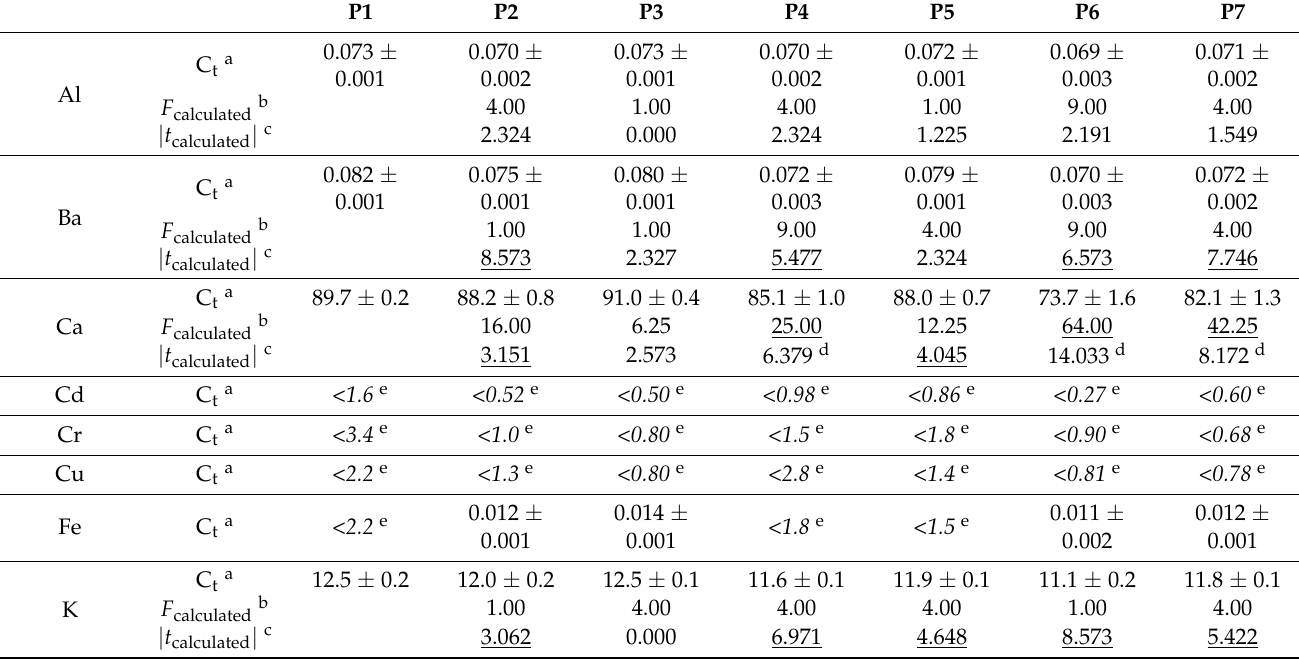
Table 2. Total concentrations of elements determined in solutions of the YM5 drink using ICP-OES and different sample preparation procedures (P1–P7) along with calculated values of the F -test ( F calculated ) and the t -test ( | t calculated | ) for the statistical comparison of standard deviations (SDs) of average concentrations of elements and these average concentrations respectively determined using alternative sample treatments (P2–P7) against the reference sample preparation procedure